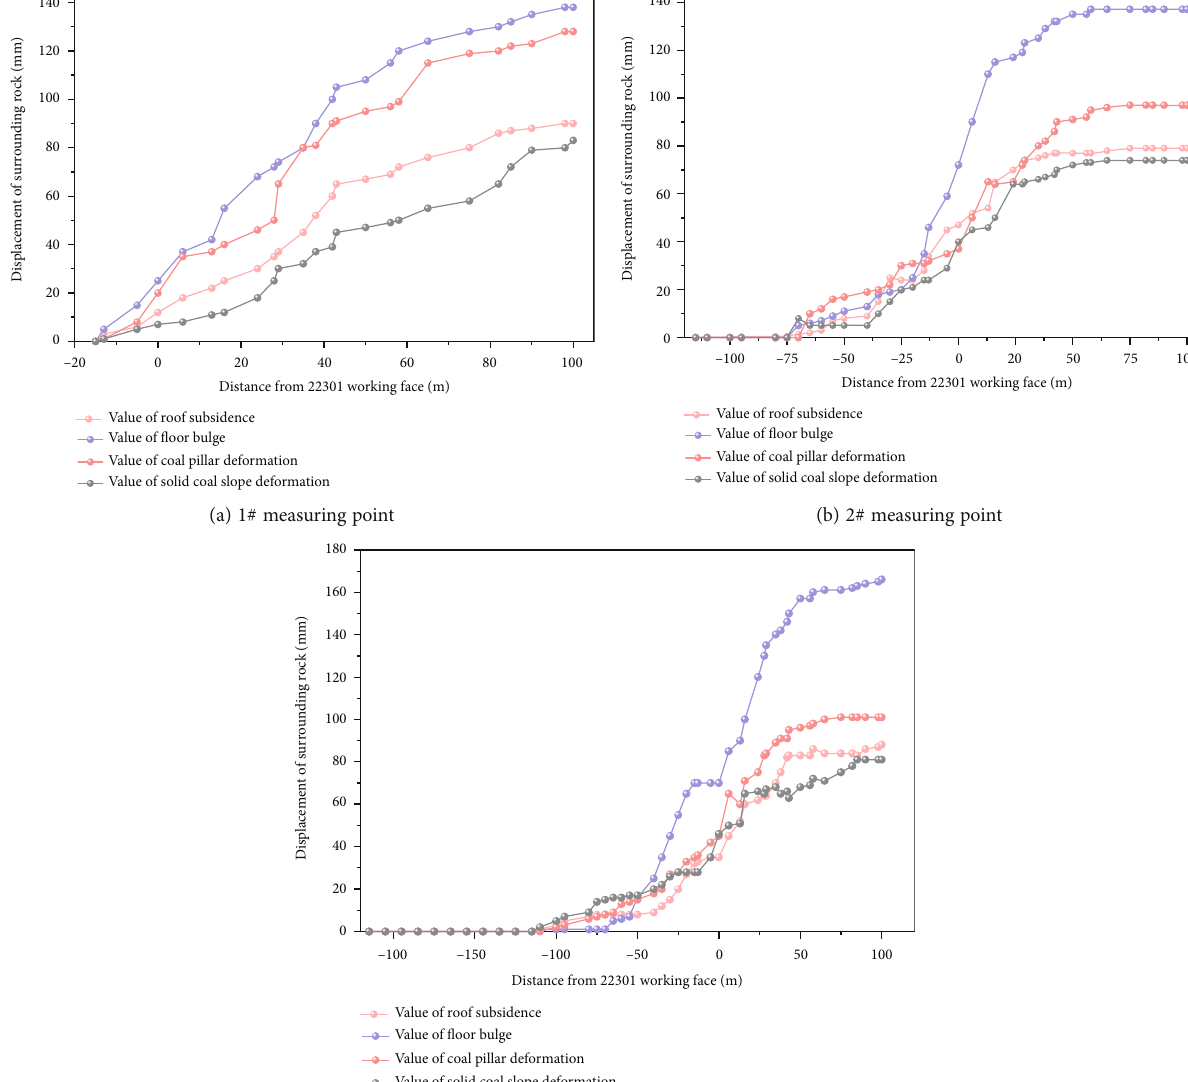
(b) 2# measuring point